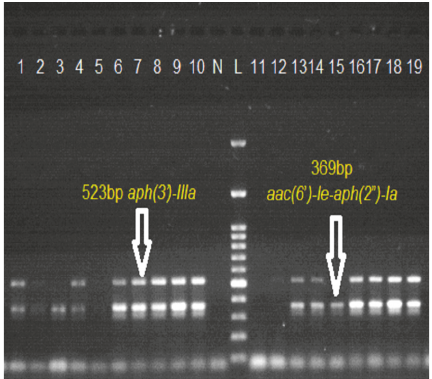
Figure 4: Representative image of gel electrophoresis of PCR for detecting Aminoglycoside modifying enzyme (AME) genes. Lane 1: positive control ( E. faecium ATCC 51299). Lane N: negative control ( E. faecium ATCC 29212). Lanes 4, 6, 7, 8, 9, 10, 13, 14, 16, 17, 18, and 19: positive; showing band at 523 bp aph(3 󸀠 )-IIIa gene and 369 bp aac(6 󸀠 )-Ie-aph(2 󸀠󸀠 )-Ia gene . Lane L: molecular marker (100bp).